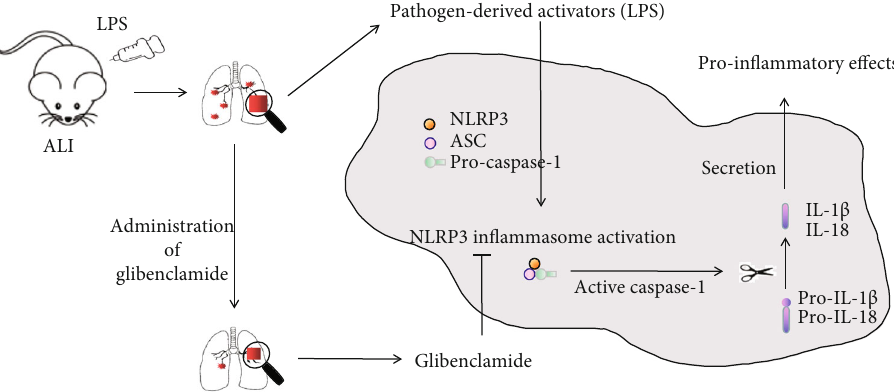
Figure 5: Schematic diagram of the role of glibenclamide on NLRP3 in fl ammasome in the pathogenesis of LPS-induced ALI. Glibenclamide blocked the activation of NLRP3 in fl ammasome induced by LPS and thus reduced the release of proin fl ammatory cytokines and then attenuated the lung injury